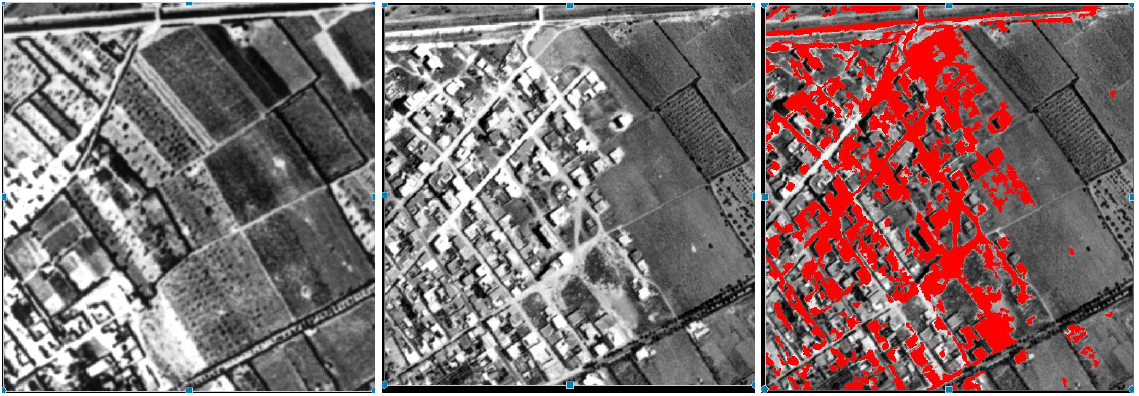
An example of the result obtained by running an automatic change detection algorithm on the first two images, representing the outskirts of Pisa in 1954 and 1968. Urban expansion over 14 years is highlighted in red in the picture on the far right ( c (cid:13) MiBAC-ICCD, Aerofototeca